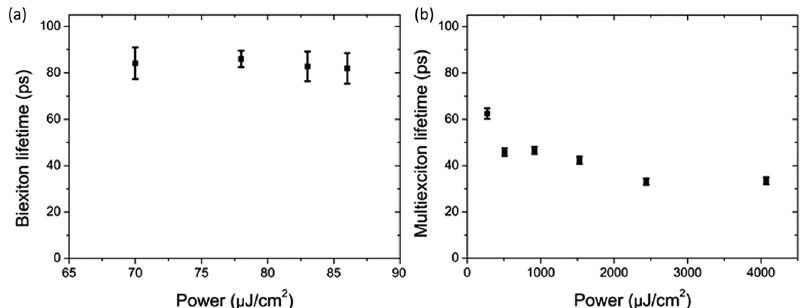
Figure 5: (a) The biexciton lifetime, after subtracting the contribution of a single excited nanocrystalline to the single exponential function, is obtained by fitting the lowest excitation pump flow. (b) After subtracting the contribution of a single excited nanocrystal line to the single exponential function, the multiexciton lifetime is determined by fitting the dynamics obtained for the highest excitation pump flow